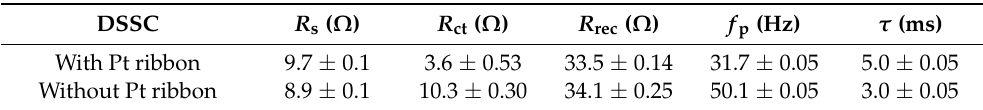
Table 2. Series resistances ( R s , R ct and R rec ), peak frequencies ( f p ) of Bode plots and electron lifetimes ( τ ) for DSSCs with and without a Pt